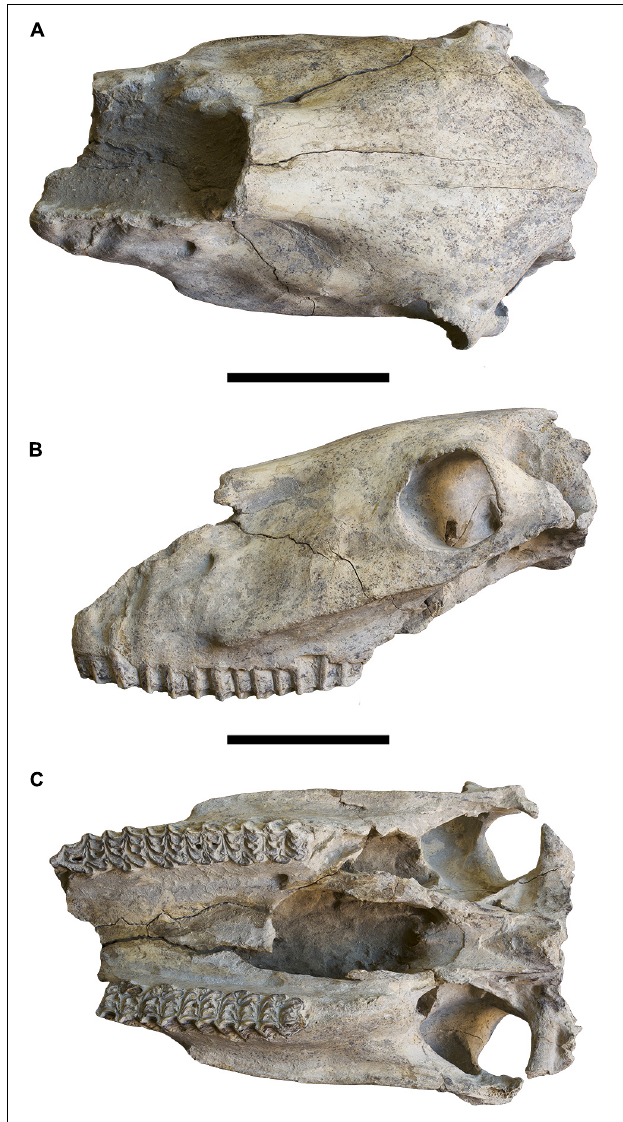
FIGURE 2 | Equus stenonis Dm 5/154.3/4.A4.5, from the Georgian locality of Dmanisi. (A) Cranial view; (B) lateral view, left side; (C) ventral view. Scale bar 10 cm.